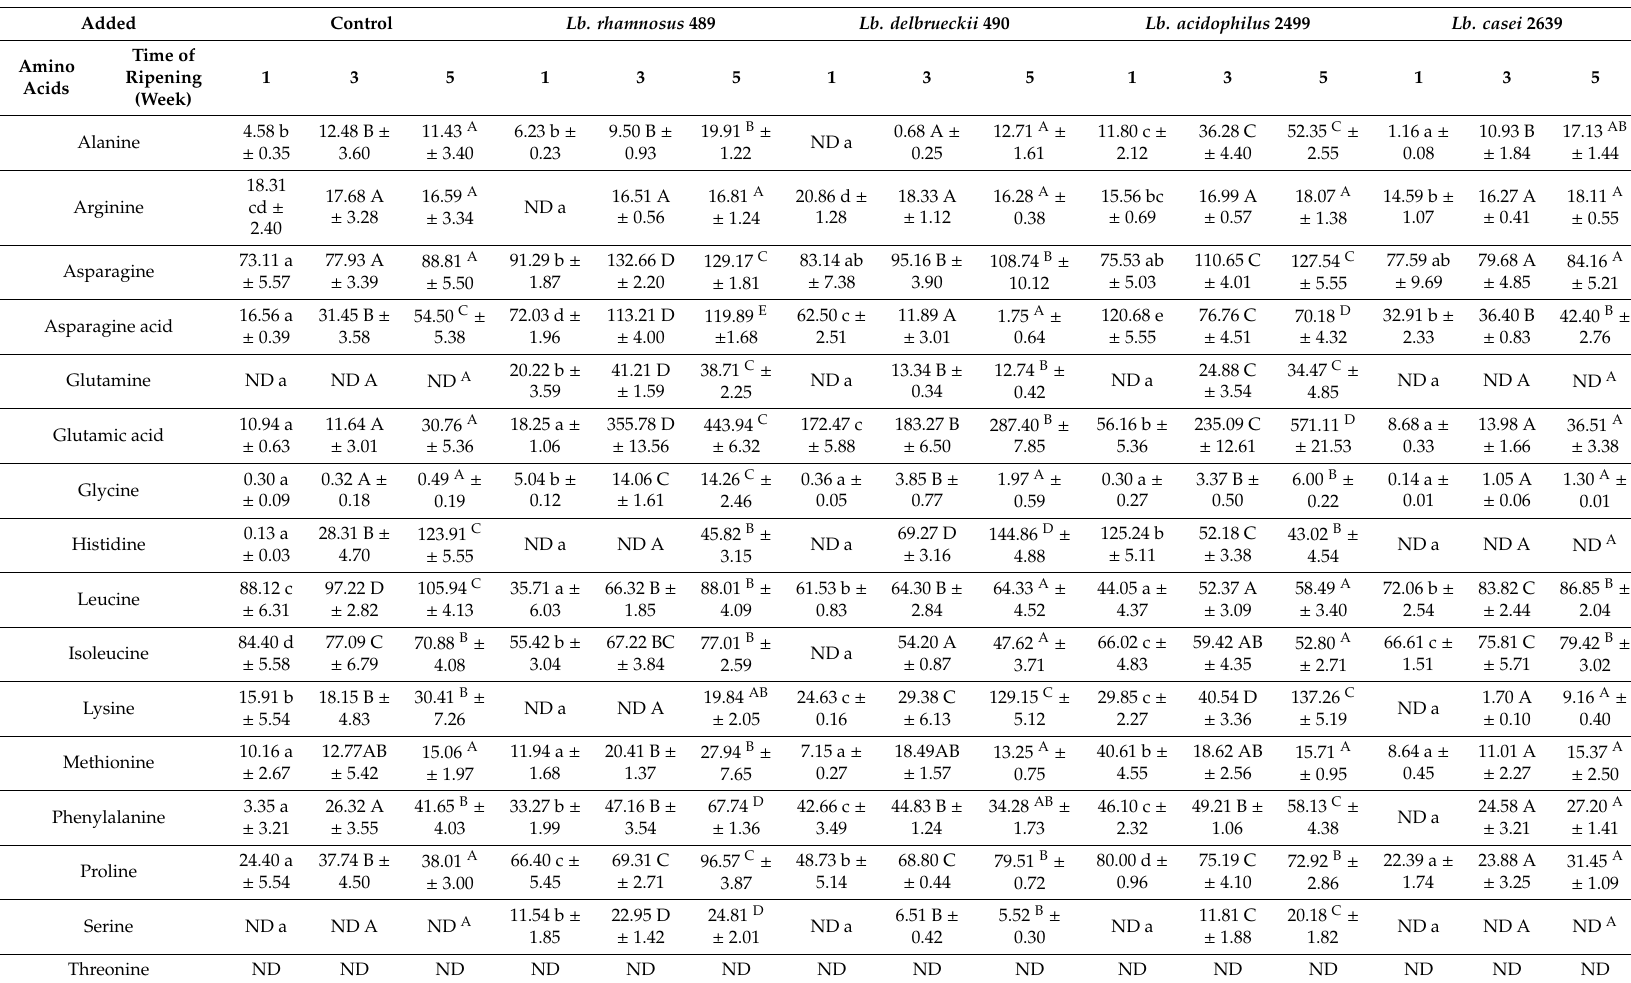
Table 1. Concentration of individual and total free amino acids (TFAA) in Dutch-type cheese models during ripening (mg kg − 1